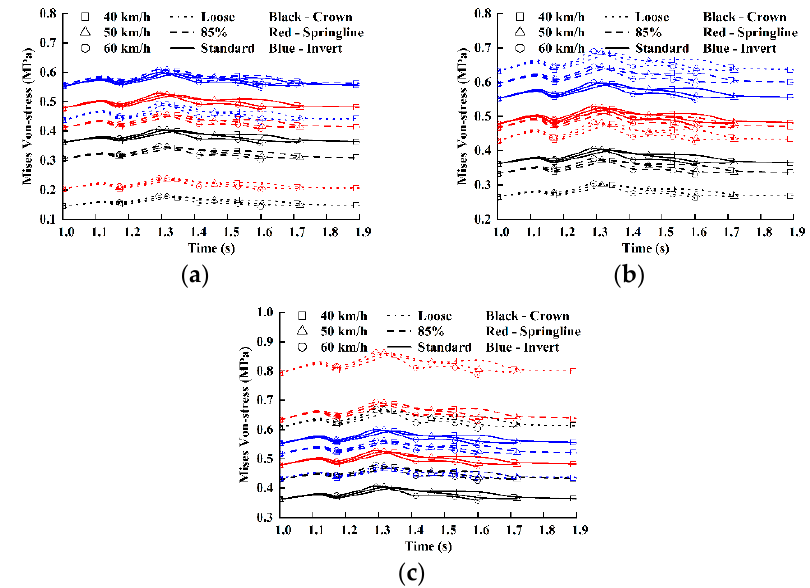
Figure 12. The Von-Mises stress under different load speeds: ( a ) change in L1 compaction degree; ( b )